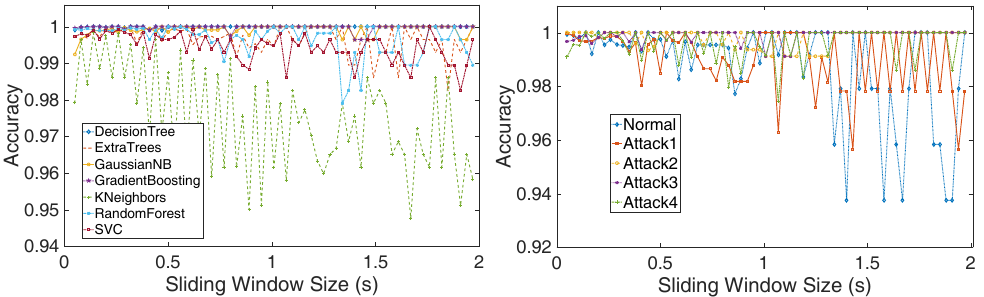
Figure 11. The influence of sliding window size t s , the overlap time t o is set to t s /2. ( a ) The detection accuracy decreases as window size increase with binary or multiclass SVM, when the window size is about 0.2 s, the algorithms have better performance; ( b ) The detection accuracy of the normal program is lower than the other attacks, which means some normal samples have been classified as other samples but the other attacks sample was not easy to misclassify.